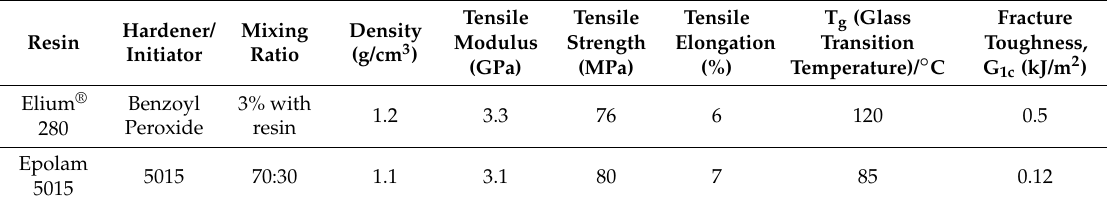
Figure 1. Free radical polymerisation of Methyl methacrylate (MMA) monomer to Poly Methyl methacrylate (PMMA) polymer with peroxide initiator [13]. Table 2. Properties of chosen resin systems in current research.